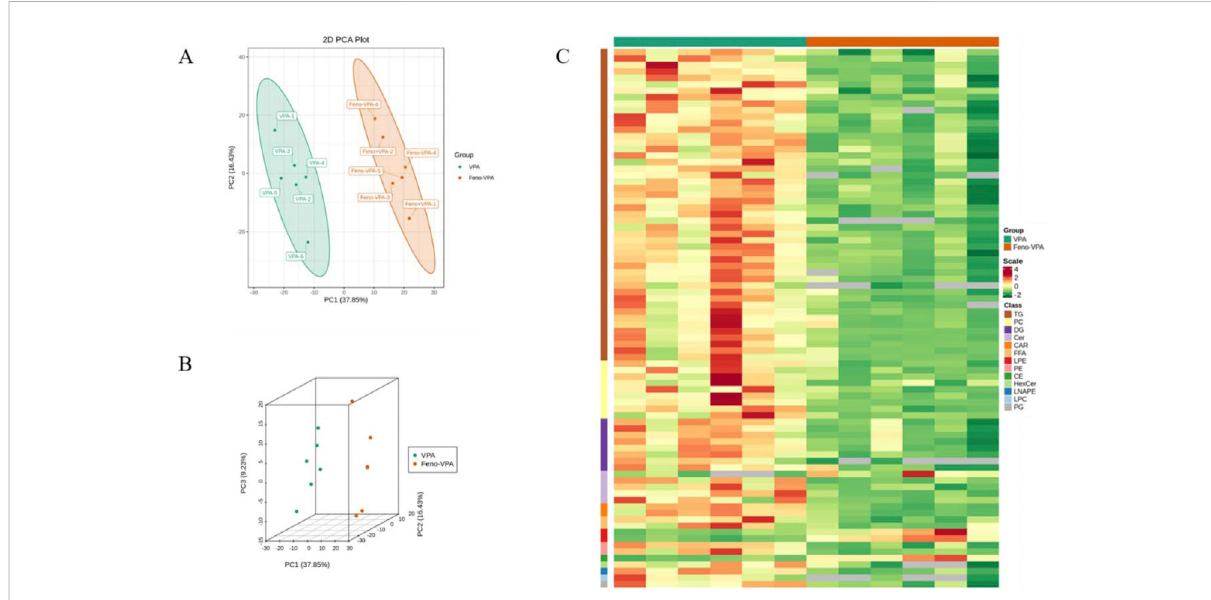
FIGURE 11 Alteration ofplasmalipid compositioninVPA-induced hepatotoxicmice byFeno. (A – B) Principalcomponentanalysis betweenthetwogroups